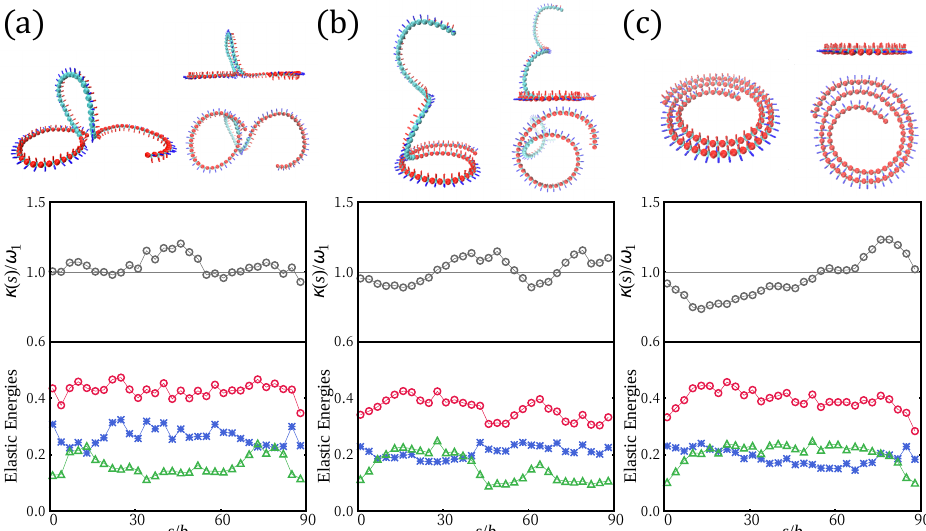
Figure 6. Three representative shapes of adsorbed H-filaments ( γ > 1) at: ( a ) (cid:101) = 0.4; ( b ) (cid:101) = 0.8; and ( c ) (cid:101) =1.6. The localized parts are shown in red. The middle panels show measured local curvatures κ ( s ) relative to the preferred curvature ω 1 = 0.181. Local curvatures κ ( s ) = over several similar conformations along the contour s . Lower panels show twist energy density (green (cid:52) ), bending energy density (blue ∗ ), and the sum of these two (red ◦